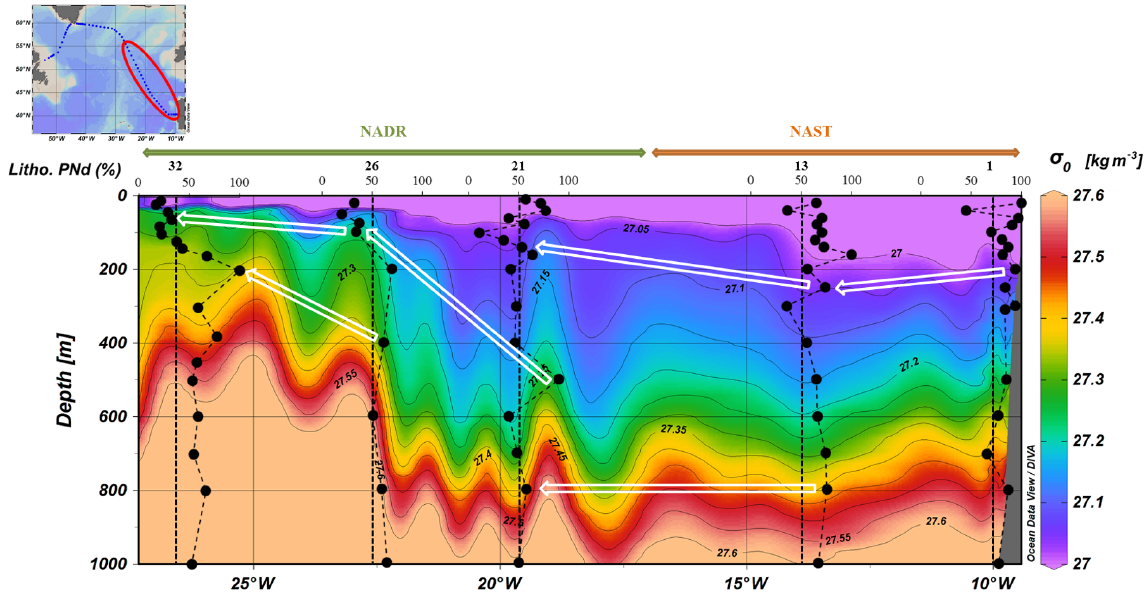
Figure 6. Estimated fraction of lithogenic PNd in the upper 1000m superimposed on density from station nos. 1 to 32. White arrows follow the high lithogenic fractions spreading along the isopycnals σ 0 = 27 . 05 and σ 0 = 27 .